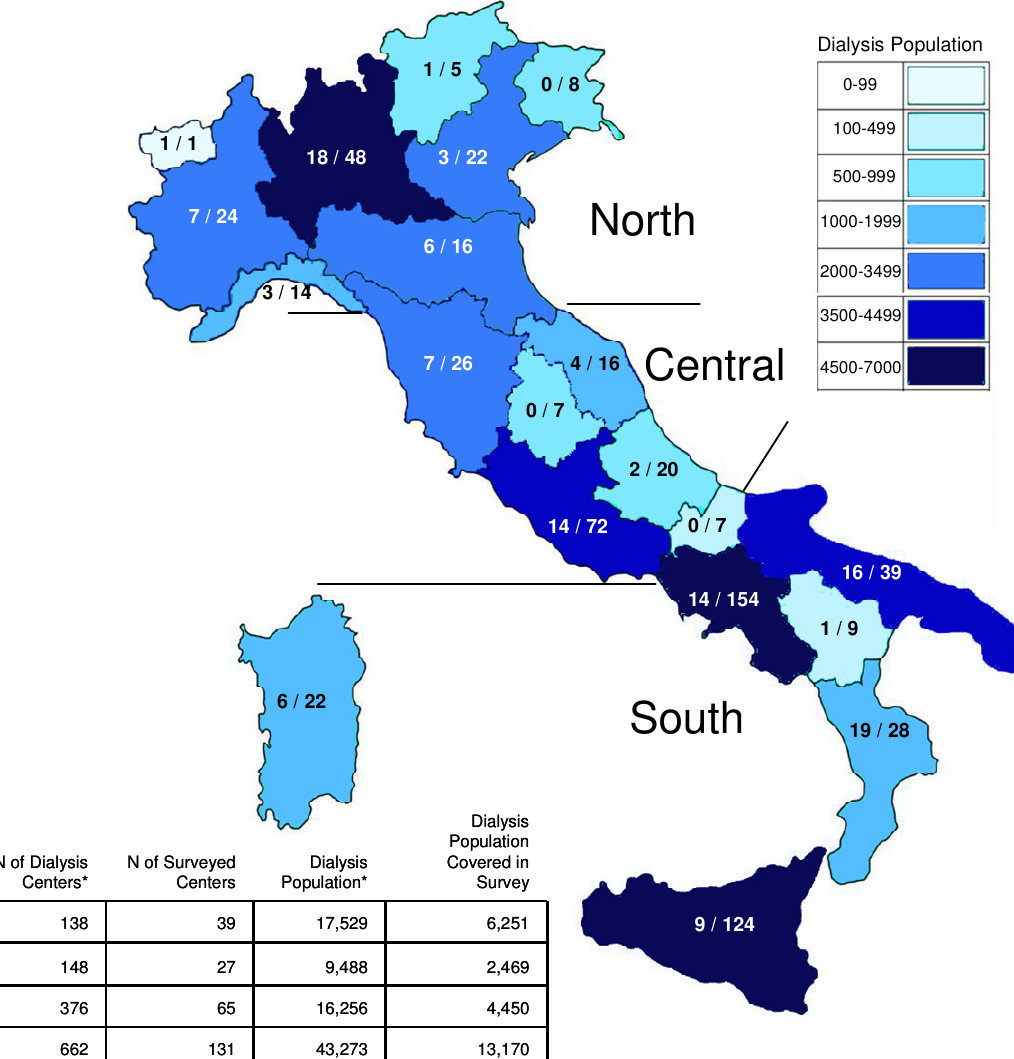
FIGURE 1. Survey results by geographic